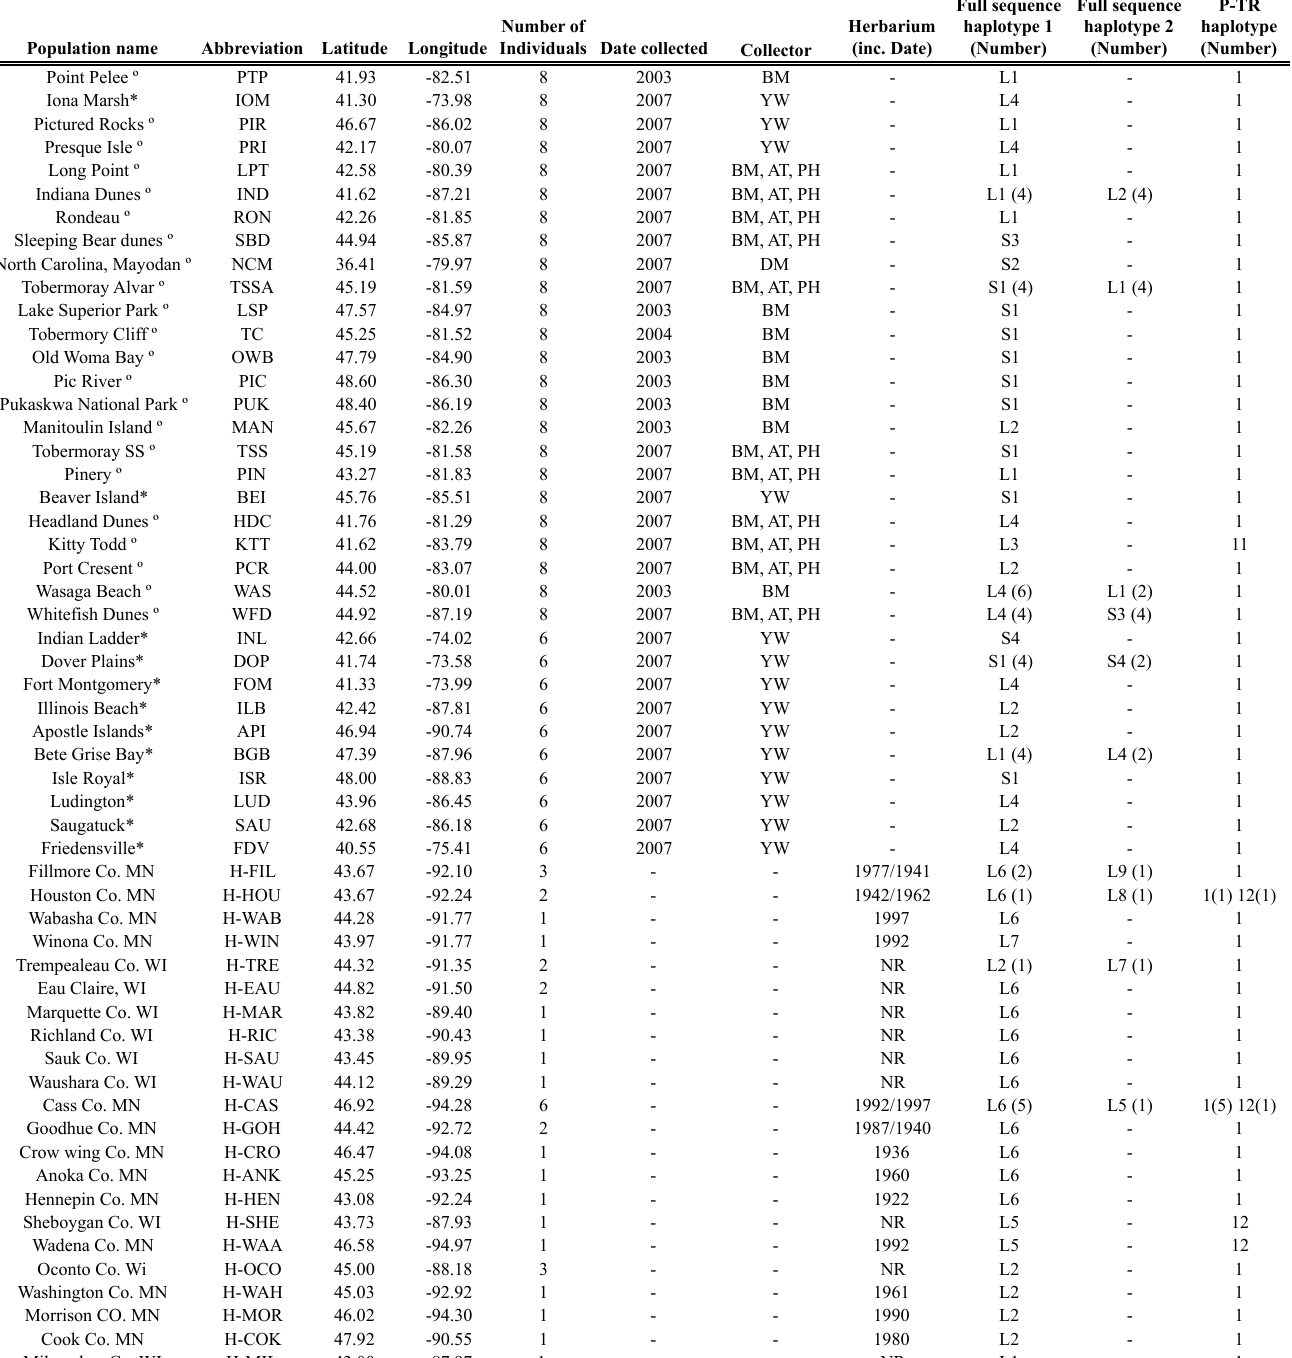
Table 1. Sampled populations of Arabidopsis lyrata , geographic co-ordinates, date collected, collector and trn F haplotypes. Haplotype assignments are based on the P-TR assignment method and the full sequence haplotype method. º Data taken from Foxe et al. [21]. * New populations described in this paper and collected by Yvonne Willi